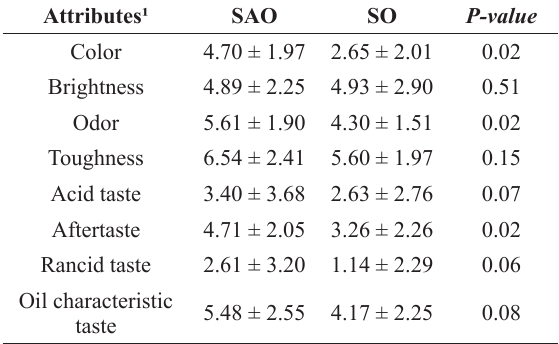
Averages ± standard deviation of sensory attributes evaluated by trained assessors in egg samples of quails fed diets with soybean acid oil (SAO) or refined soybean oil (SO).